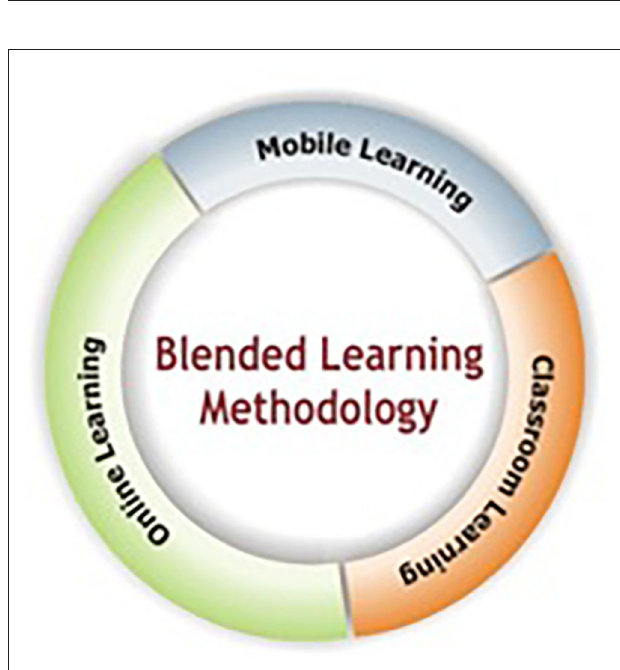
FIGURE 3 | Blended e-learning